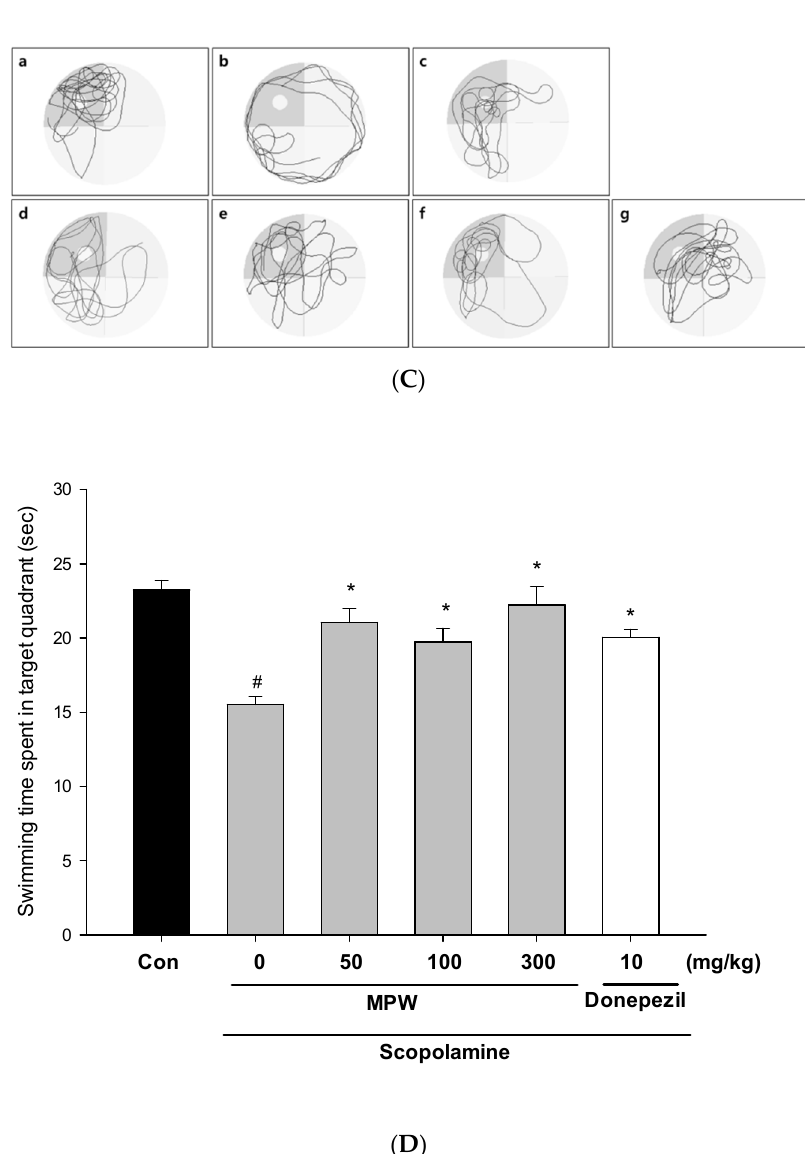
Figure 8. Effect of MPW on scopolamine-induced spatial learning and memory impairment in mice. Animals